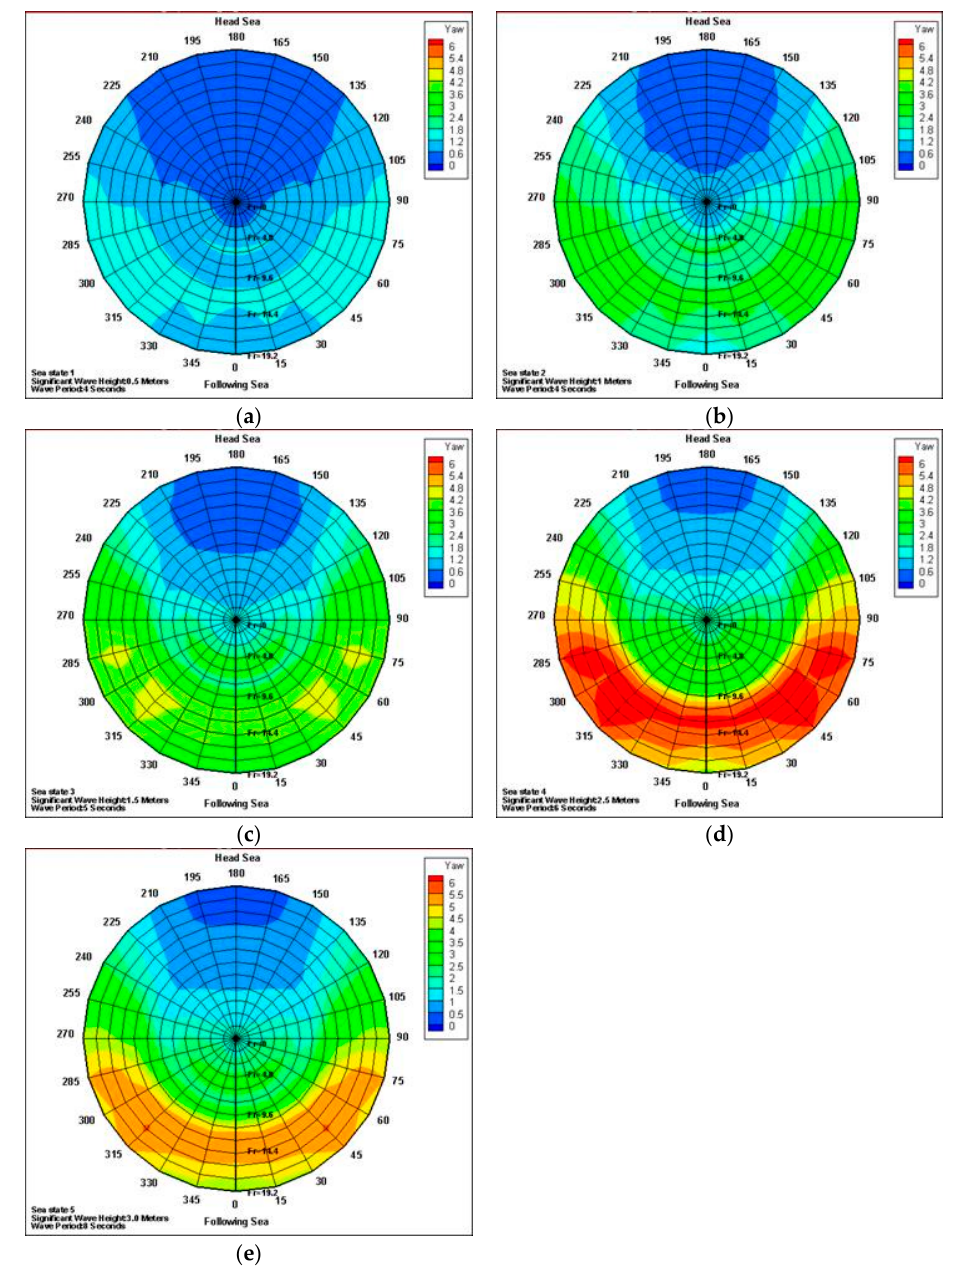
Figure 15. Speed polar diagrams of yawing motion at various sailing speeds for different heading angles when sea state was ( a ) 1, ( b ) 2, ( c ) 3, ( d ) 4, and ( e ) 5, respectively.